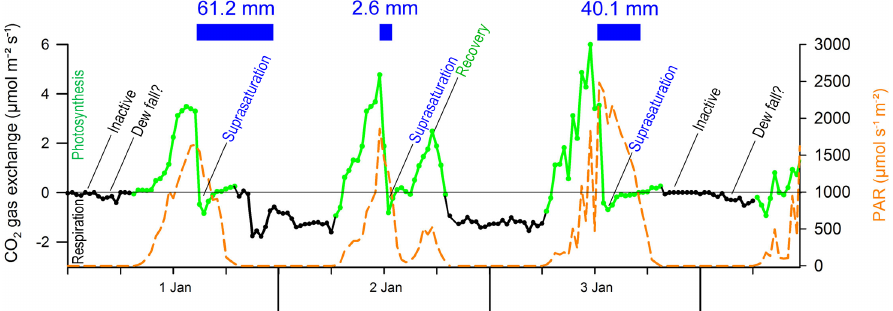
Figure 5. Detail of diurnal CO 2 gas exchange from January 2011, showing rain events resulting in water supersaturation of the biocrust. Blue bars indicate the approximate duration of rainfall. Green lines indicate gas exchange during daylight and black lines during the night.